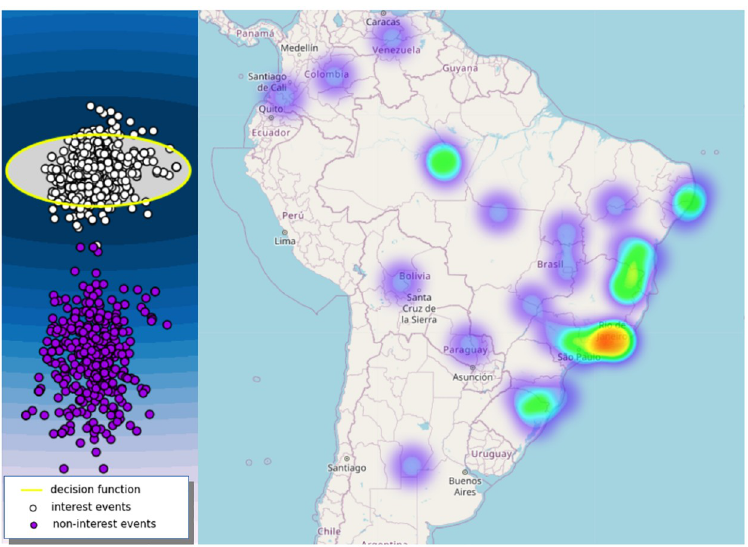
Fig 5. Sensor map about Brazilian Covid-19 events. Base map and data from OpenStreetMap and OpenStreetMap Foundation.